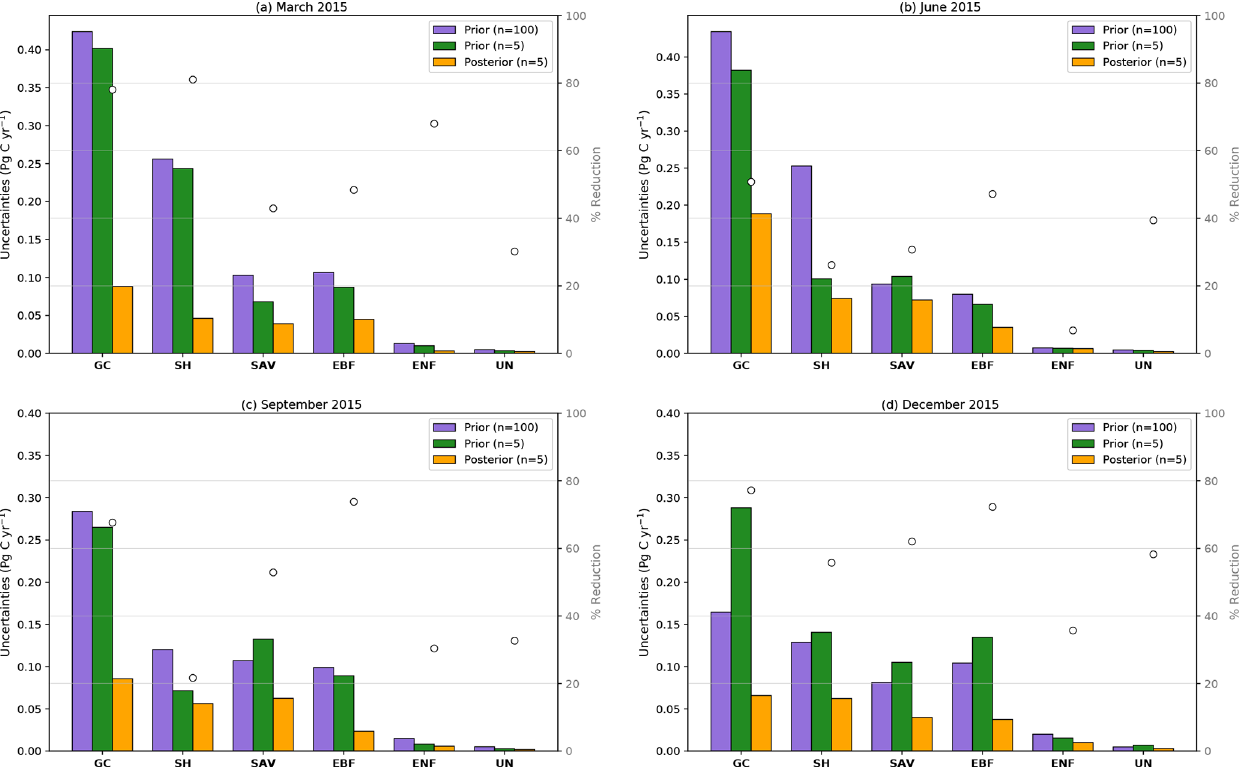
Figure 7. Prior and posterior uncertainties (in PgCyr − 1 ) aggregated over five different classes over the Australian domain using MODIS Land Cover Type Product (MCD12C1). Green and orange bars represent the prior and posterior uncertainties of five realizations, respectively, while the purple bar represents prior uncertainties of 100 realizations. Circles show the percentage of uncertainty reduction by each